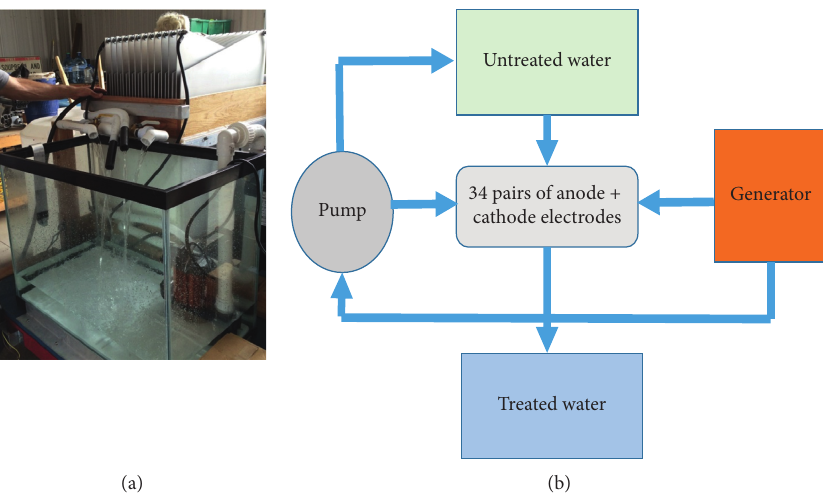
Figure 2: (a) Prototype electrocoagulator. The top part is a water treatment unit made of steel tank housed in a wooden frame and 34 pairs of aluminum electrodes bolted to steel rods. The reactor is powered by direct electrical current via a generator. Treated water is channeled into glass holding tank at the bottom. (b) Schematic of the electrocoagulator showing the key components: generator, pump, holding tanks for treated and untreated water, and reaction chamber